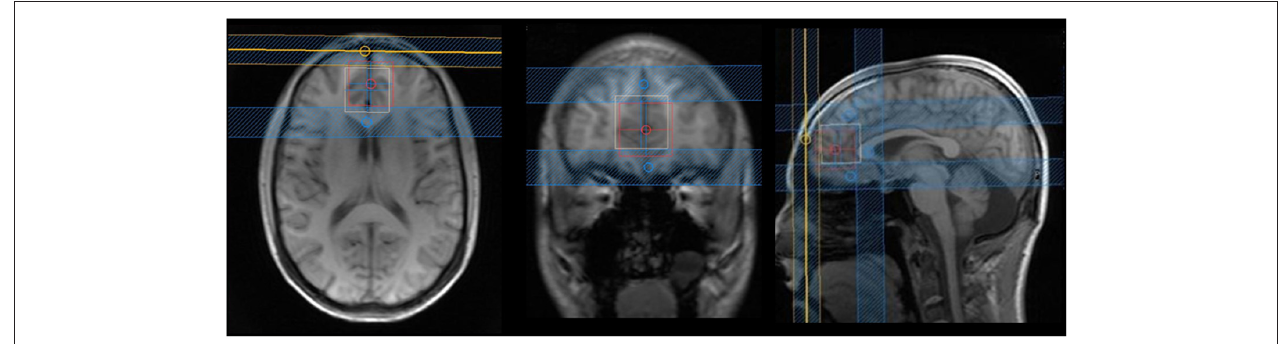
FIGURE 1 | Axial, coronal, and sagittal images from the voxel position in the ventromedial prefrontal cortex: blue lines are suppression bands, used in the Y- and Z-axes. We analyzed that only the voxel that was the overlap between the white and red squares in order to reduce effects of chemical shift voxel displacement. The following rationale was used: the bottom portion of the voxel was aligned with the anterior–posterior commissure; in the anterior/posterior axis, the corpus callosum was used as reference (just ahead of the genu of corpus callosum); and in the lateral axis, the voxel was situated in the most medial portion of the